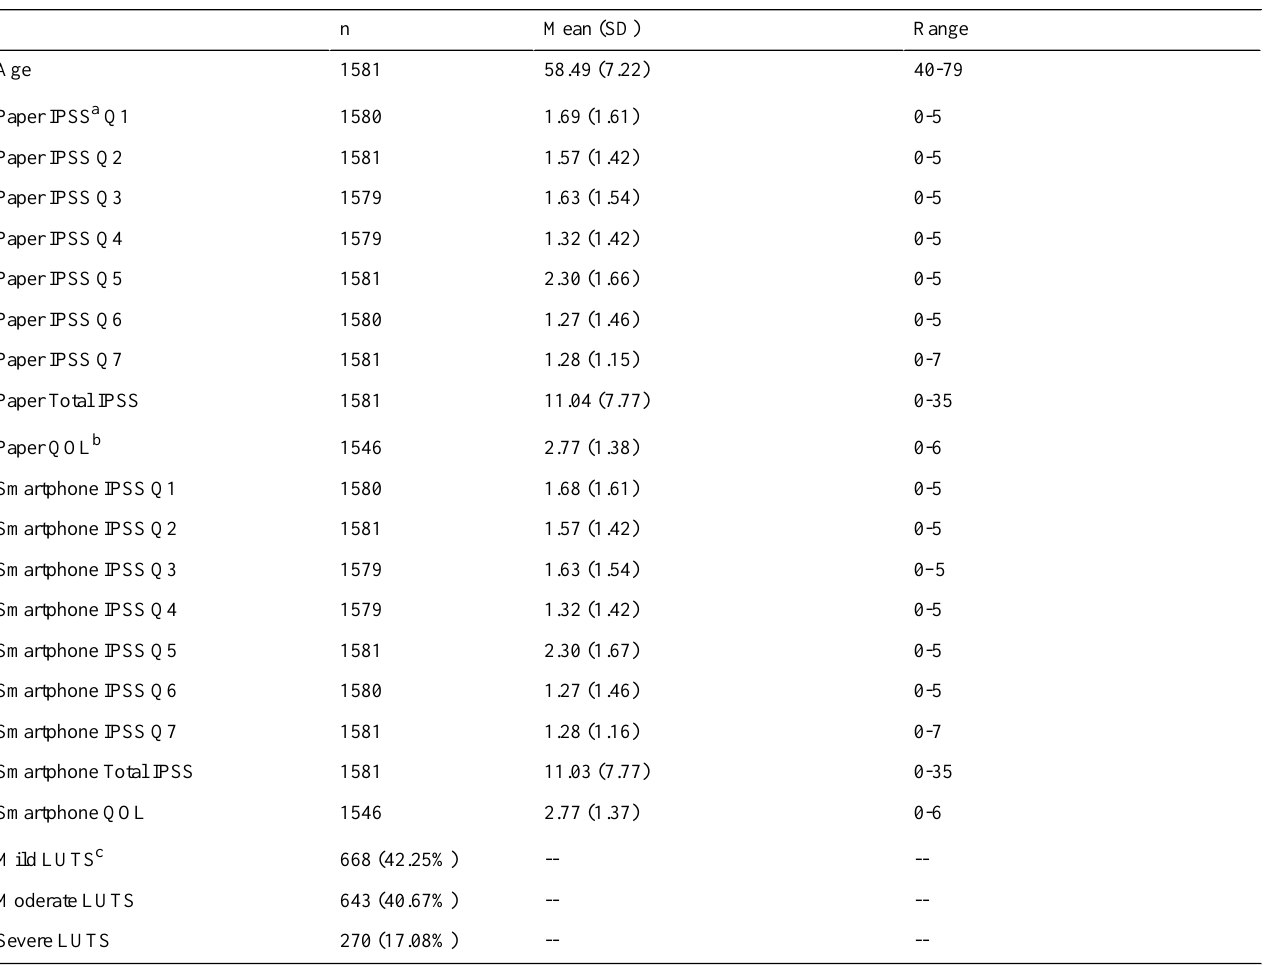
Table 1. Baseline characteristics